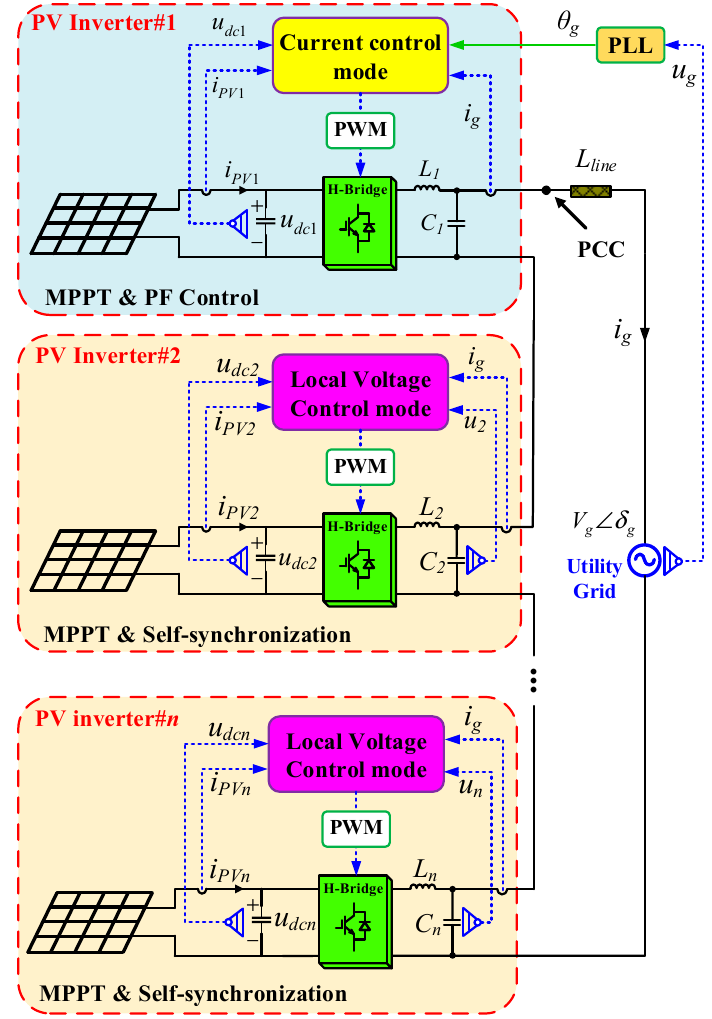
Figure 2. Overall control framework of the proposed method.